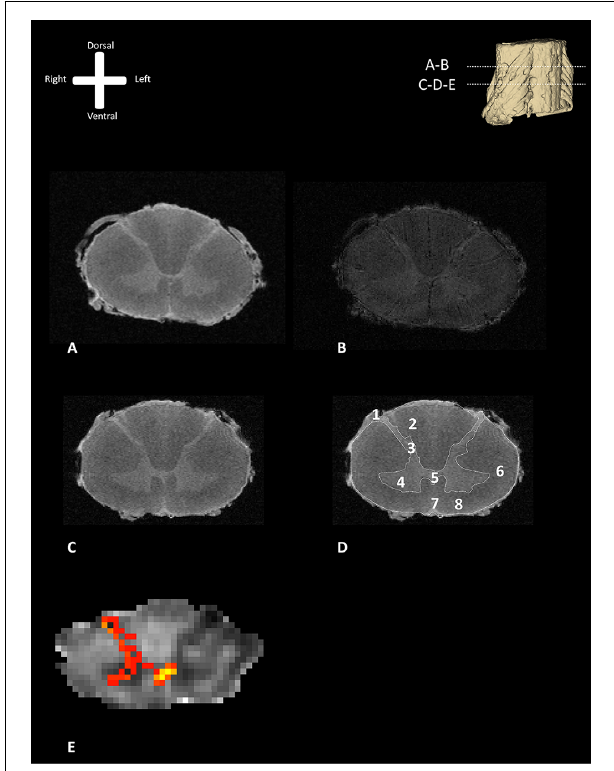
FIGURE 1 | Transverse section of one of the human cervical spinal cords (specimen 1) as depicted with different MR-techniques. 3D model in the viewers right corner shows the level of the transverse sections depicted as subfigures (A,B) . (A) T1-weighted anatomical image of a transverse section of the human cervical spinal cord. (B) T2 ∗ -weighted anatomical image of a transverse section of the human cervical spinal cord. (C) T1-weighted anatomical scan without annotations. (D) T1-weighted anatomical scan with annotations; 1: dorsal root entry zone (DREZ), 2: dorsal columns, 3; dorsal horn, 4: ventral horn, 5: posterior gray commissure, 6: lateral column, 7: anterior median fissure, 8: anterior column. (E) Maximum intensity projection (MIP) of the tractography reconstruction of a transverse section of the spinal cord showing afferent pathways. Tractography is superimposed on a fractional anisotropy (FA) map. The afferent bundle bifurcates into a lateral and medial bundle. The lateral bundle contributes to the uncrossed spinothalamic tract, whereas the medial bundle decussates via the anterior white commissure (AWC) to contribute to the crossed spinothalamic